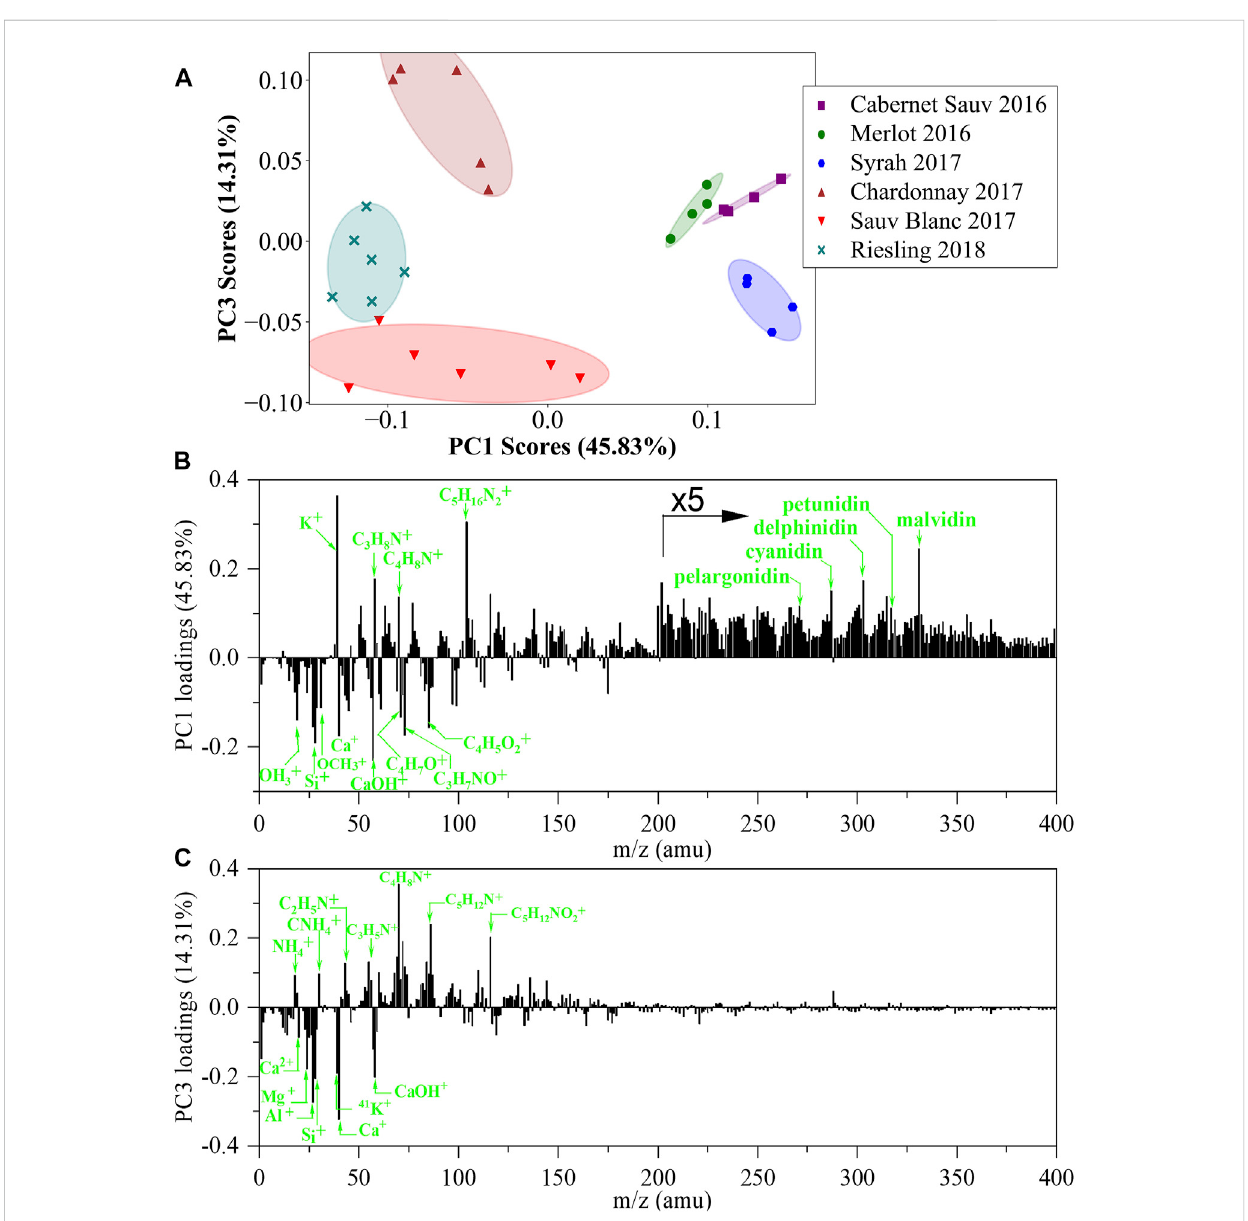
PCA analysis of in situ liquid SIMS spectra from the six representative wines from a single manufacturer in positive mode. (A) Scores plot of the fi rst principal component (PC1) versus the third principal component (PC3) from the spectra of in situ liquid SIMS. (B) Corresponding loadings plot of PC1 indicating the separation between the red and white wines. (C) Corresponding loadings plot of PC3 indicating the separation between the white wines. The assignment of the top 20 positive loadings and top 20 negative loadings of PC1 and PC3 can be seen in Supplementary Tables S4,